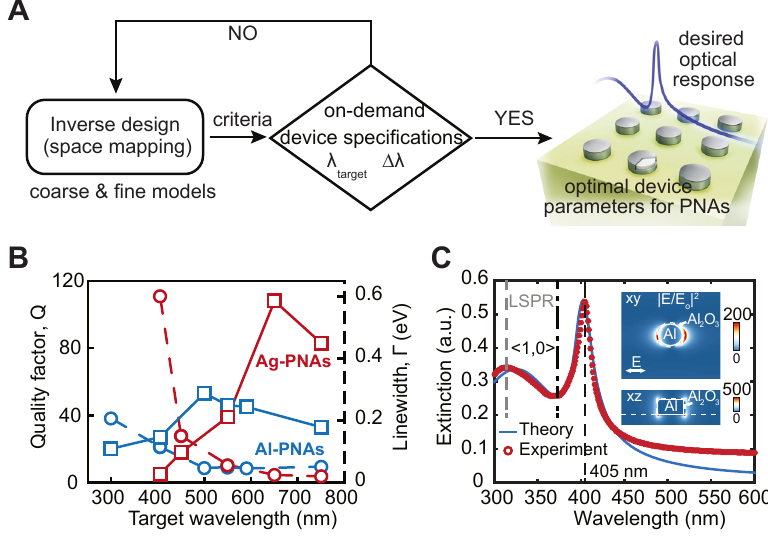
Figure 3: High Q -factor Al PNAs over a broad spectral window: (A) Space mapping algorithm enabling the inverse design of high Q -factor (narrow resonance linewidth) PNAs at the desired wavelength is shown; (B) Optical characteristics of coupled Al PNAs (blue color)